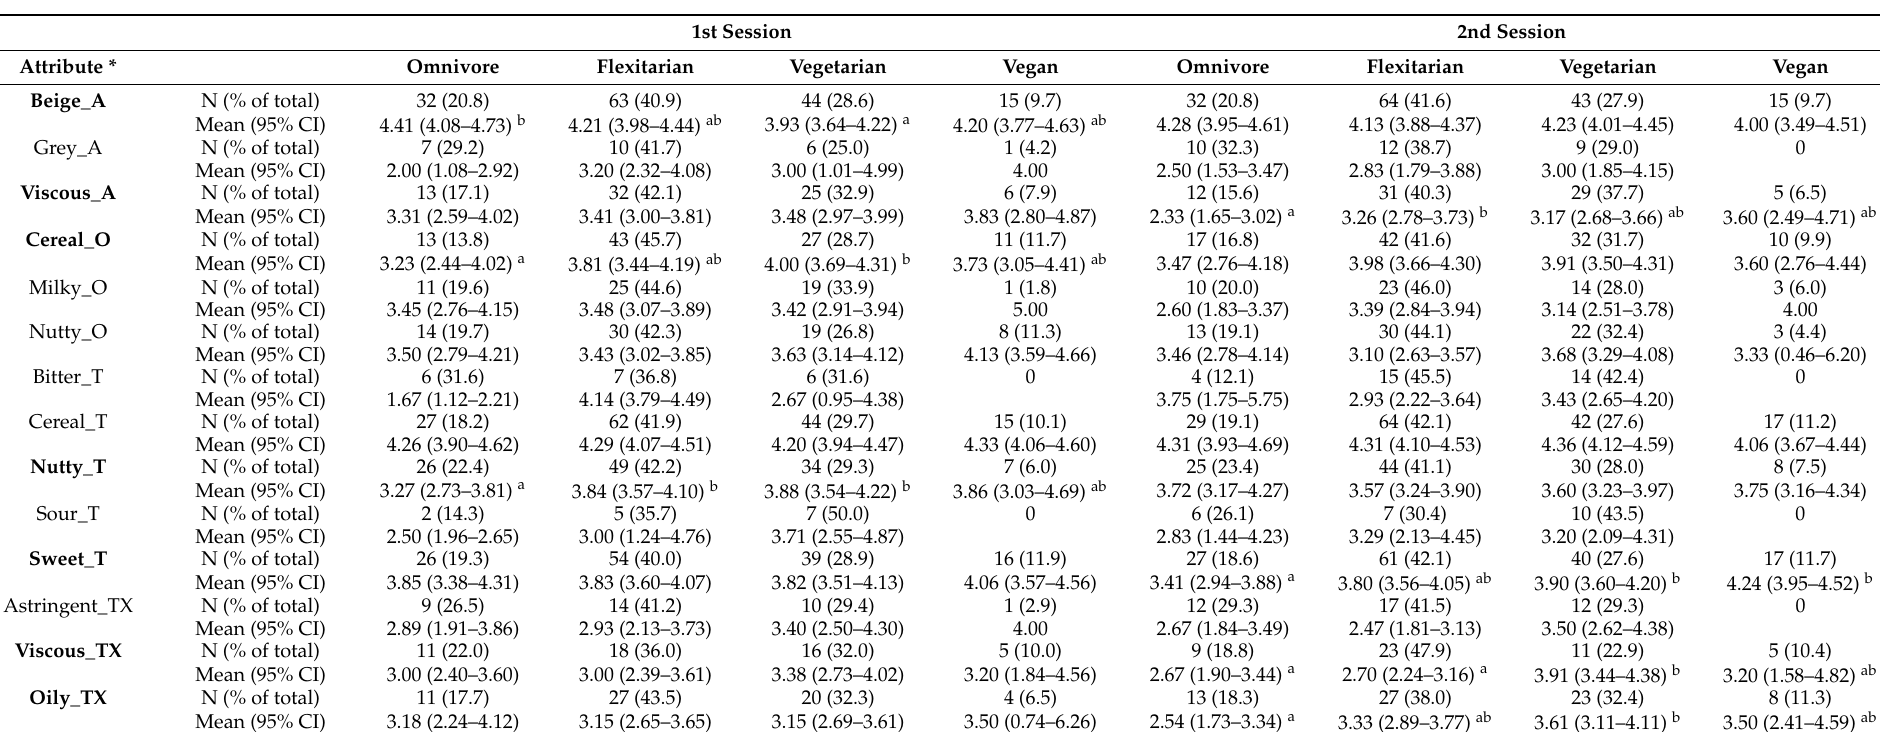
Table 2. RATA attribute evaluation of plant-based oat drink in two sessions on a 5-point scale, with different shares of 159 participants. Significant differences could be calculated for the attributes in bold